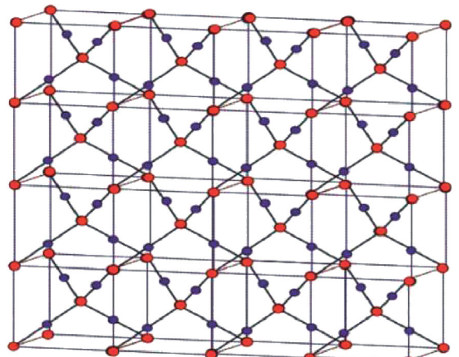
Figure 2: Copper(I) oxide [4, 4]